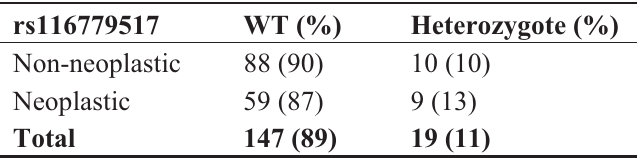
Table 2. Tanzania Cervical Cancer